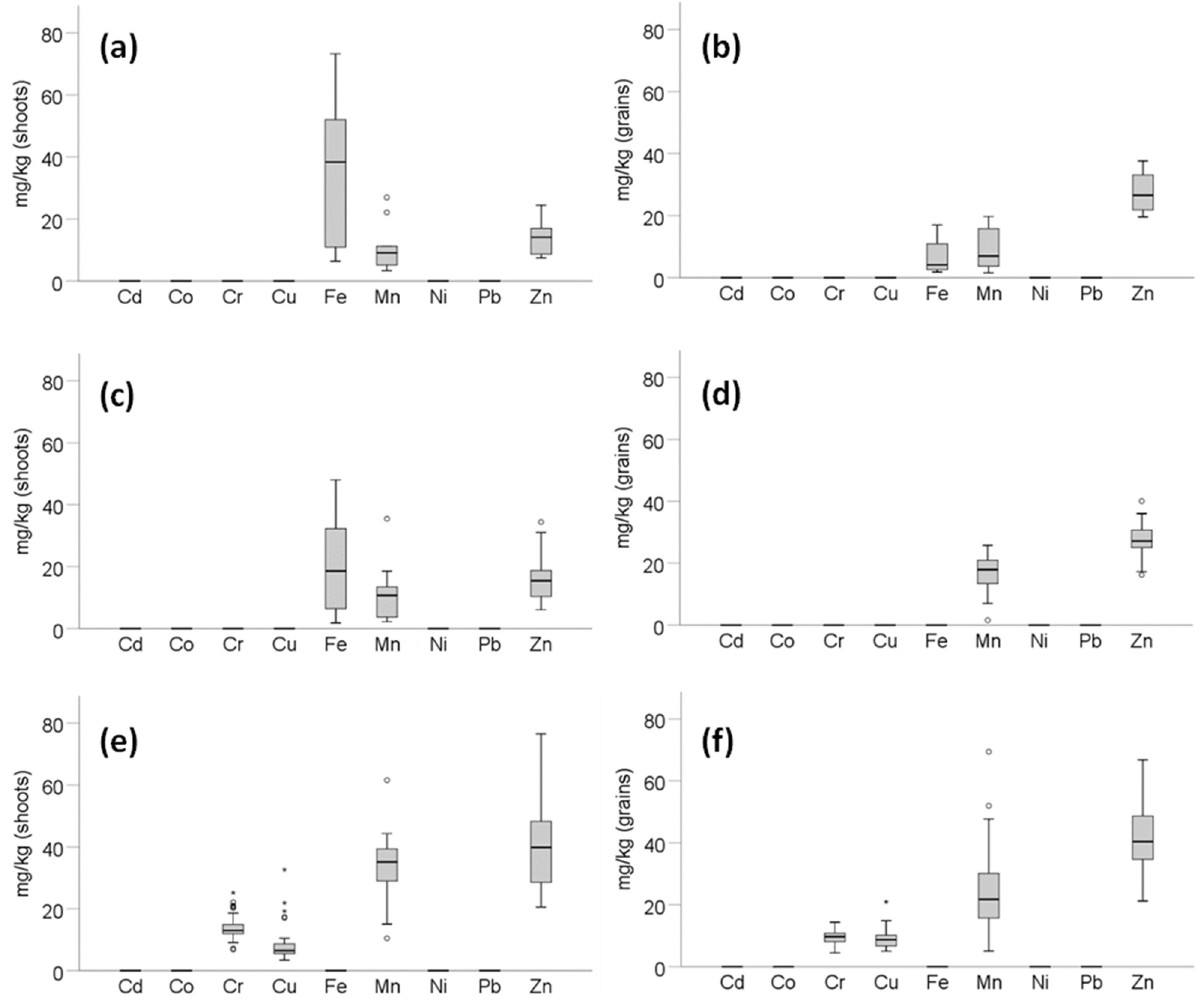
Figure 4. PTE concentrations in mg kg − 1 dry mater of shoots and grains in Eretria ( a , b ), Domokos ( c , d ) and the steel factory ( e , f ) wheat samples. Circles and asterisks denote outlier values.